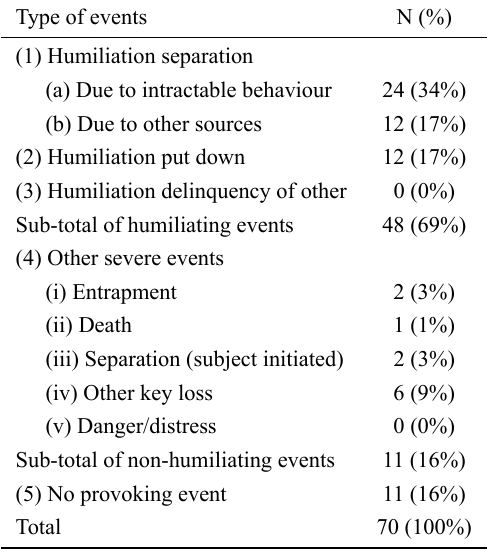
Table 2. Suicide provoking events (12 weeks period